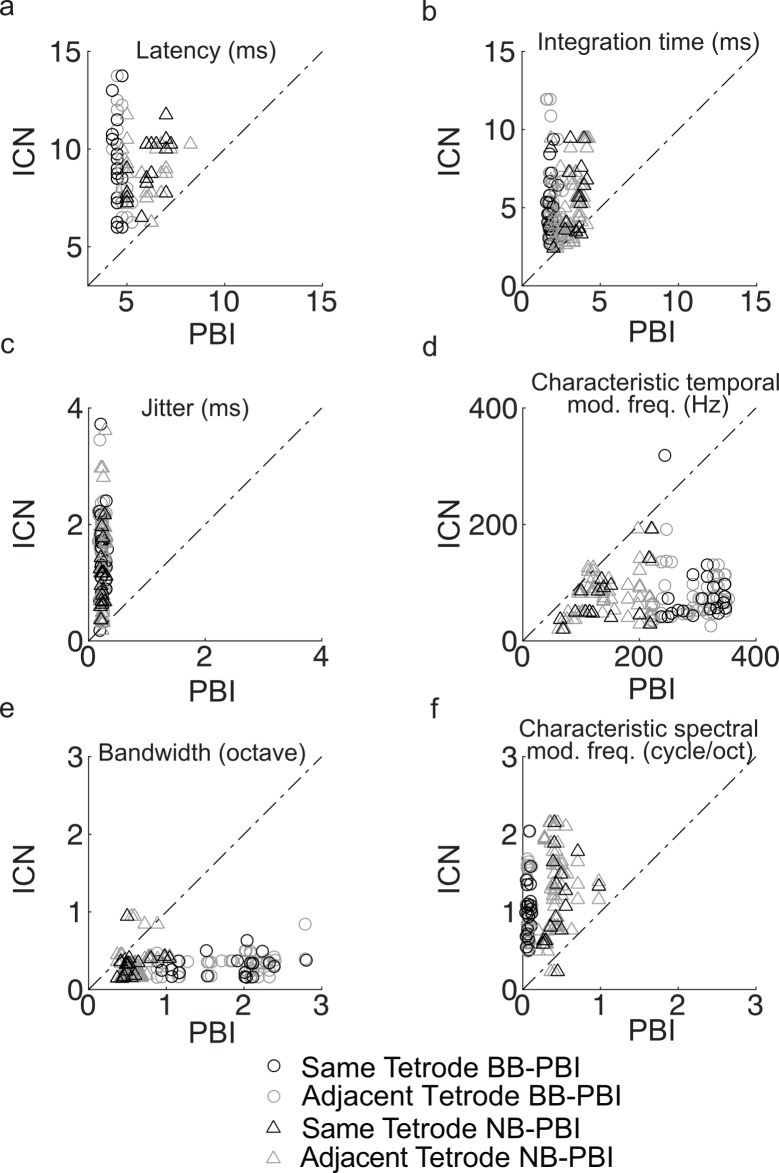
Temporal resolution degrades and spectral resolution is enhanced for ICNs.PBIs exhibit shorter response latency (panel a, 4.9 versus 8.6 ms), shorter integration time (panel b, 2.3 versus 4.3 ms), substantially higher spike-timing precision (panel c, jitter = 0.2 versus 1.2 ms), and better temporal modulation sensitivity (panel d, 222 versus 72 Hz) when compared to their paired ICNs. In contrast, ICNs have substantially narrower bandwidth than PBIs (panel e, 0.33 versus 0.94 octave) and prefer finer spectral modulations (panel f, 1.1 versus 0.2 cycle/octave). Open circle denotes broadband PBI, and triangle denotes narrowband PBI. Pairs recorded from the same tetrode are shown in black, and pairs recorded from adjacent tetrodes are shown in gray. Latency (panel a) and jitter (panel c) data are the same as Fig 2E and 2F, except that data are now grouped for broadband and narrowband PBI as well as same and adjacent tetrode pairs. Underlying data can be found in S5 Data and S5 Code. BB, broadband; ICN, inferior colliculus neuron; NB, narrowband; PBI, putative brainstem input.